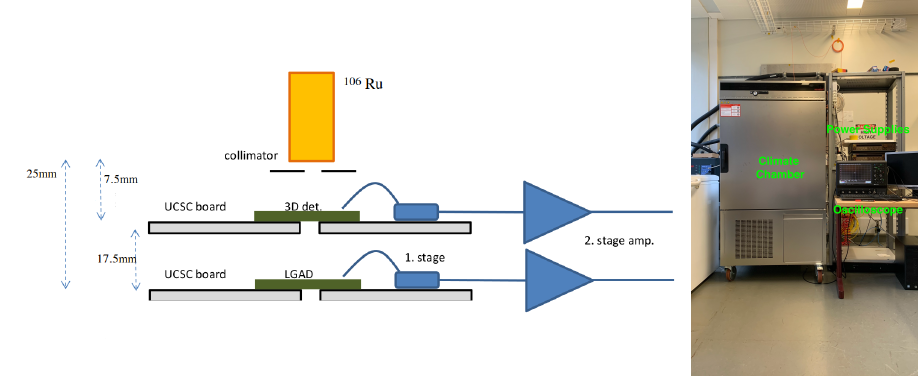
Figure 3. Experimental setup used for measurements of the time resolution.